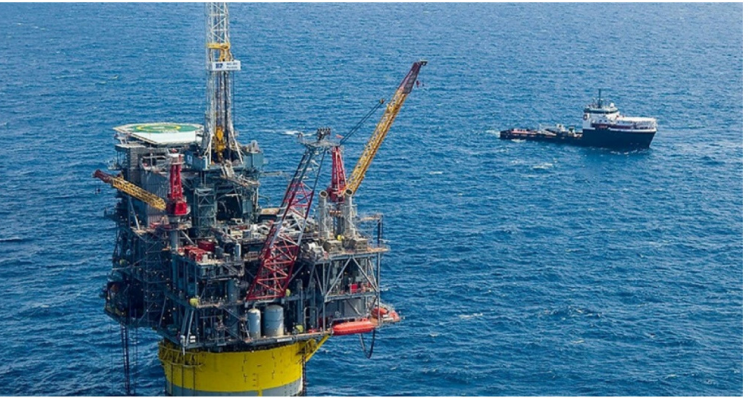
Figure 12. Perdido deep water SPAR platform in the Gulf of Mexico (GoM), (Courtesy: